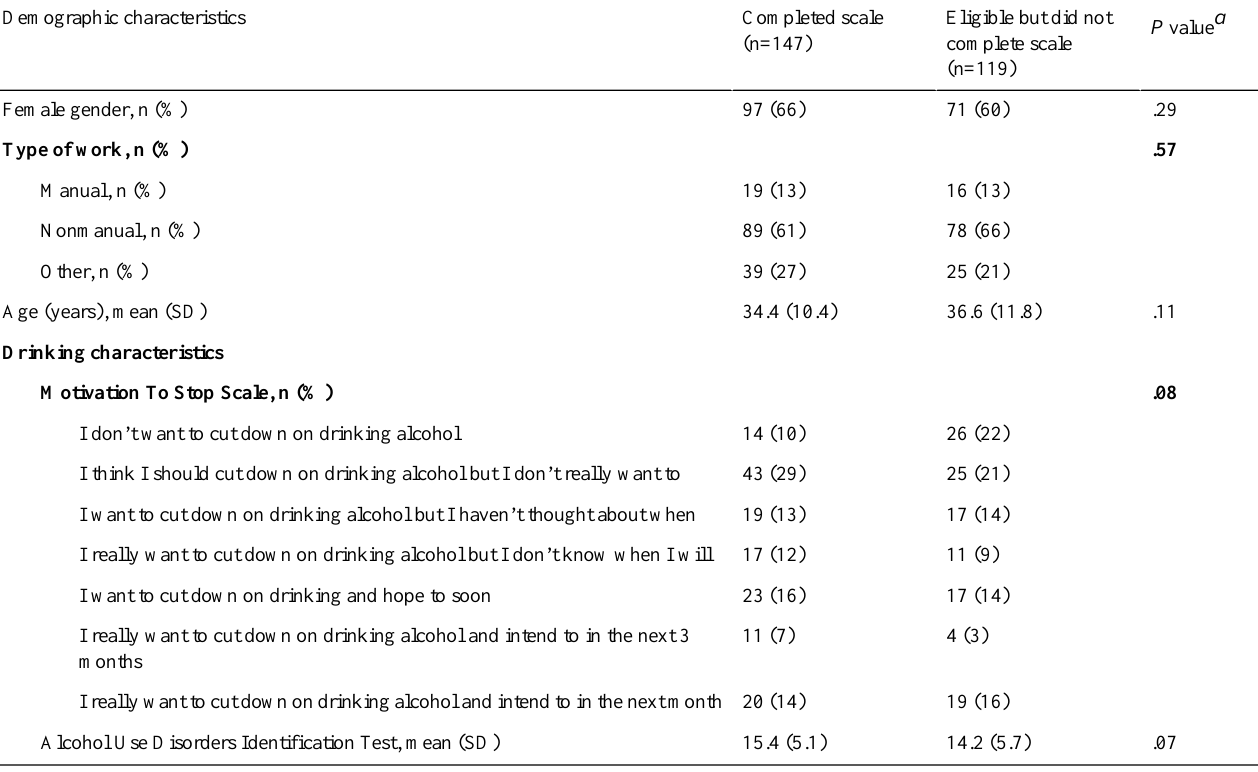
Table 1. Participants’demographic and drinking